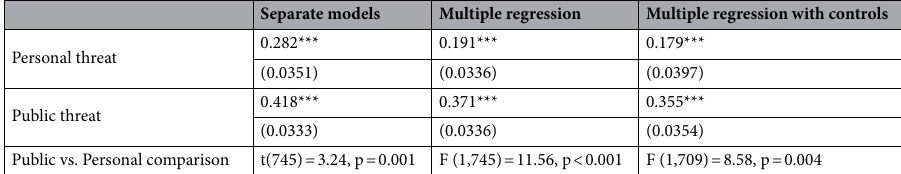
Table 7. Associations between threat variables and prevention intentions in Study 4. We report results from regressions predicting prevention intentions as a function of the composition thread variables collected in Study 4. Shown are results from (i) a set of separate regression models for each threat variable (Column 1) and (ii) multiple regression models using both threat variables (Columns 2–3). We show results from multiple regression models both with and without controls for age, gender, education, race, income, and political party affiliation. All coefficients are standardized coefficients, with standard errors for each coefficient in parentheses. For each model, we also report results from a test comparing the public versus personal threat coefficient. Standard errors in parentheses. ***p < 0.001, **p < 0.01, *p <